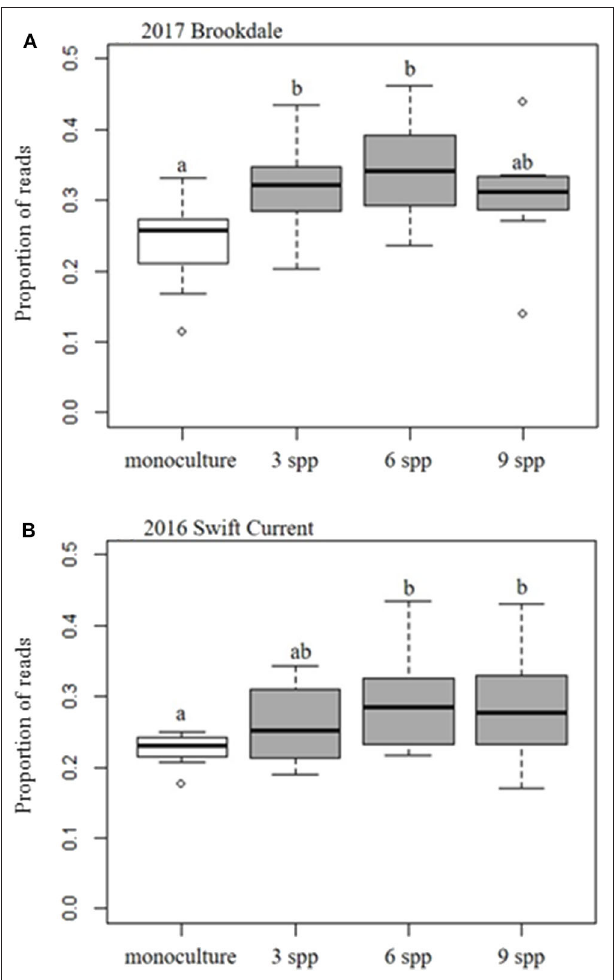
FIGURE 4 | Boxplots of the effect of cropping mixtures (monoculture, three, six, and nine spp.) on the relative abundance (proportion) of